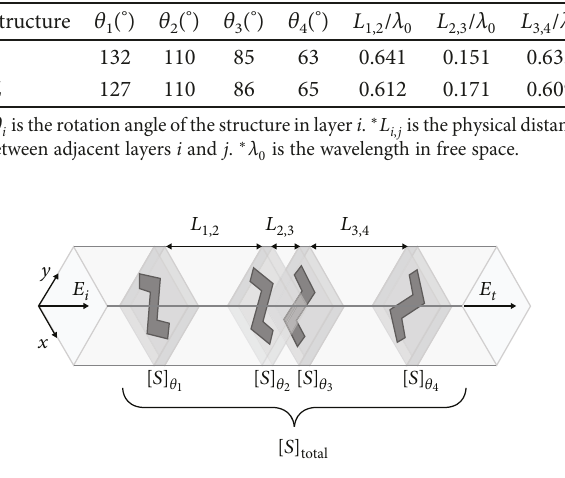
Figure 6: 3D view of a 4-layered Z -shaped LP